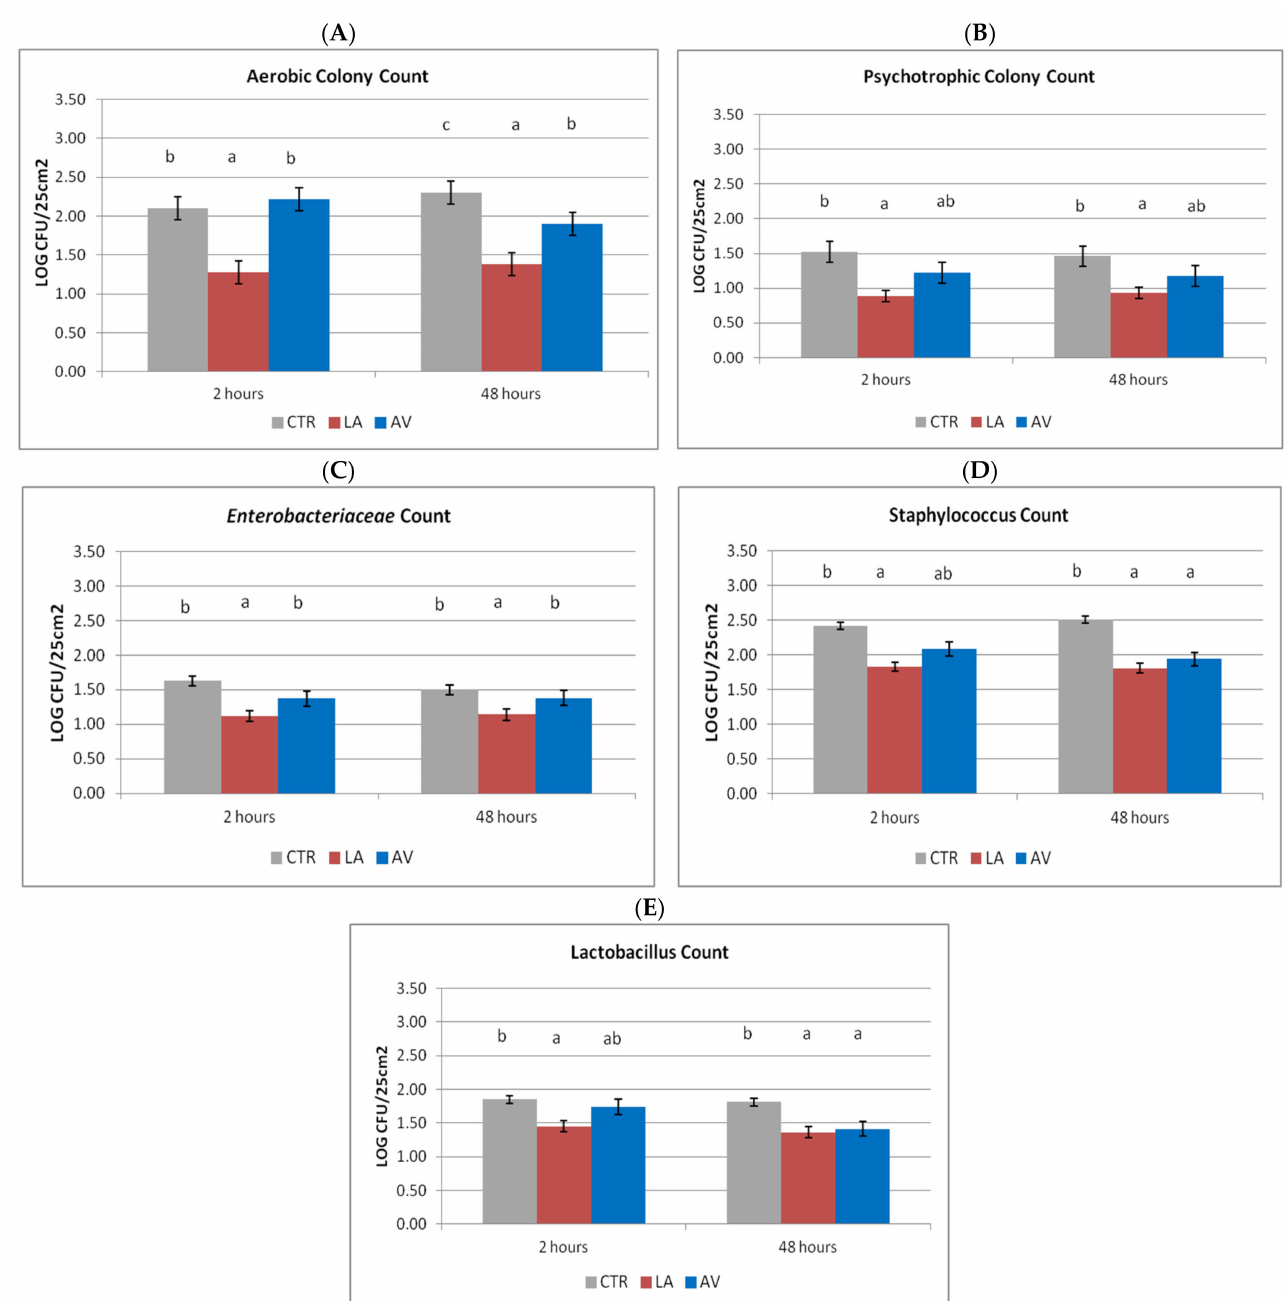
Figure 2. Aerobic colony count ( A ), Enterobacteriaceae count ( B ), psychotrophic colony counts ( C ), Staphylococcus count ( D ), and Lactobacillus count ( E ) on external surfaces of wild boar carcasses sprayed with 2% Lactic acid solution (LA), aromatic vinegar (AV), and untreated (CTR) after 2 and 48 h from the treatments. Different letters on the bars describe statistically different mean values ( p <